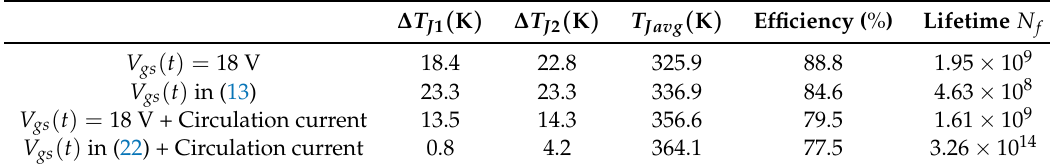
Table 9. Lifetime estimation and system efficiency for case